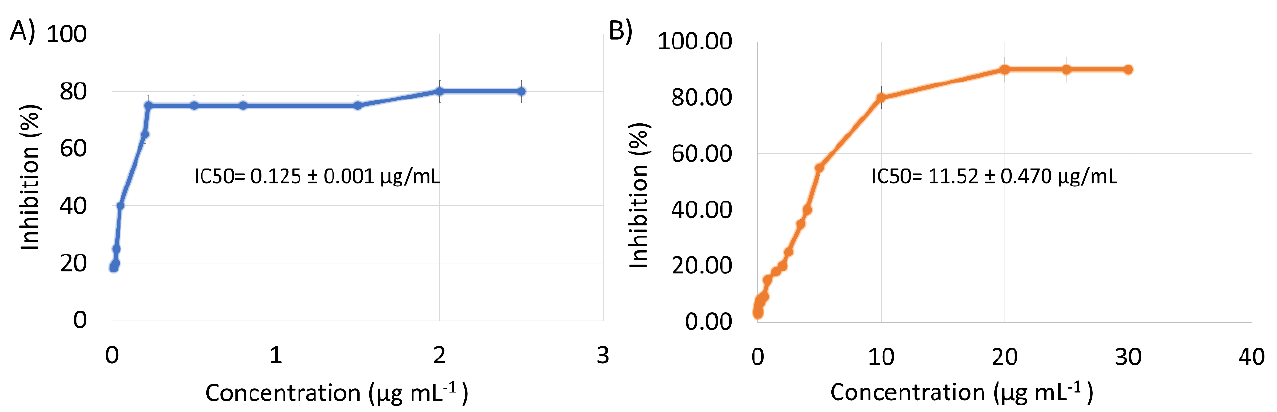
Figure 2. Dose-response curve of fraction F5 ( A ) and of the EGC standard ( B ).